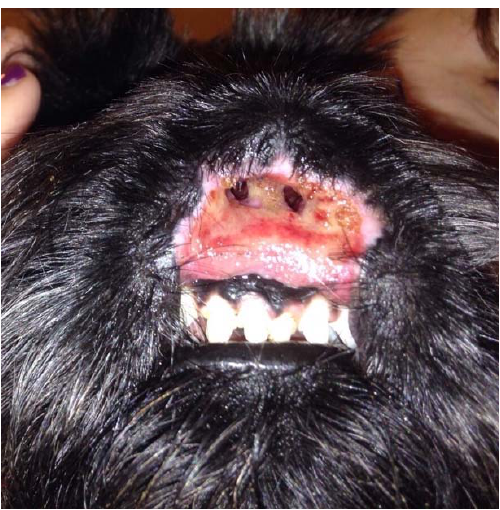
Figure 1. Wide and deep ulcer destructing and replacing the nasal planum, philtrum, and upper